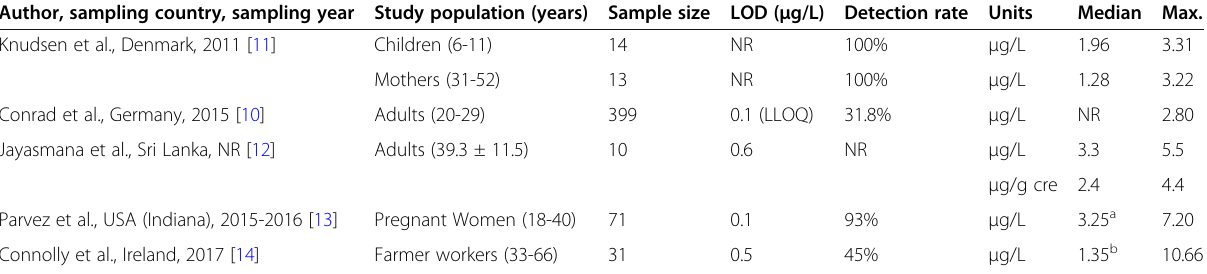
Table 8 Urinary glyphosate concentrations reported in previous